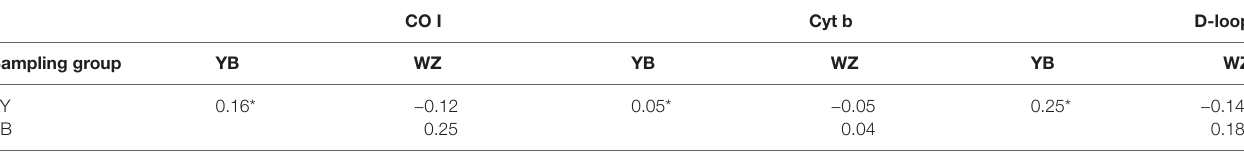
TABLE 2 | Pairwise differences ( N ST ) among the wild population (ZY), Yibin hatchery (YB), and Wanzhou hatchery (WZ) of Procypris rabaudi using partial sequences of the mtDNA CO I, Cyt b, and D-loop markers.